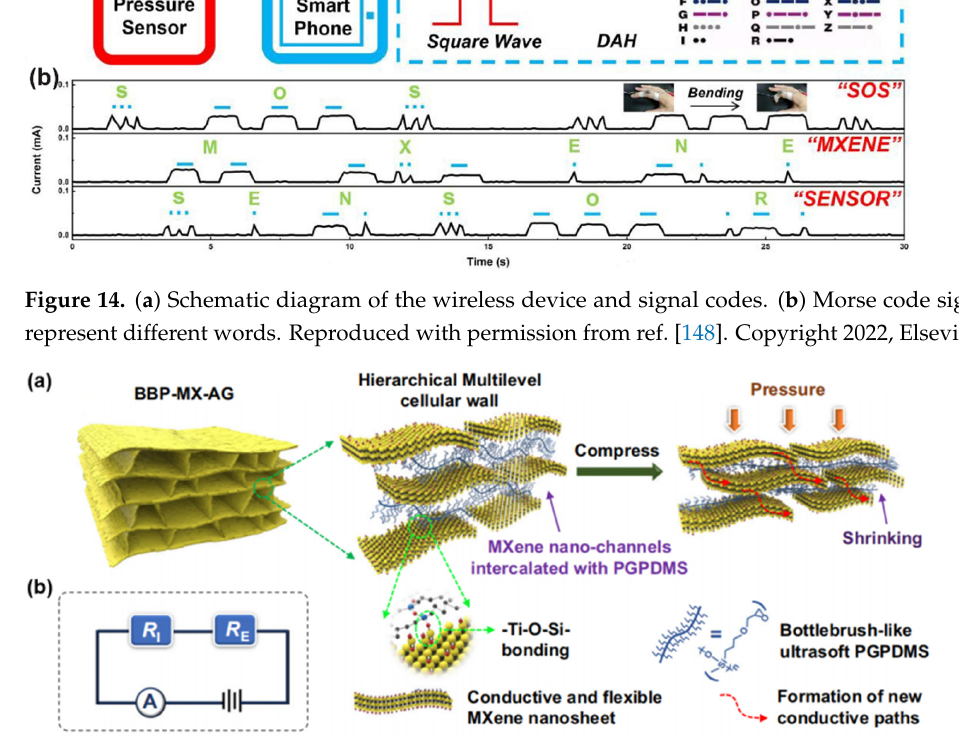
Figure 15. ( a ) Schematic illustration showing the MXene aerogel with sandwich-like structure, and the shrinking process of the multilevel cellular wall with bottlebrush-like PGPDMS crosslinked MXene nanochannels under compression. ( b ) Equivalent circuit diagram of this piezoresistive sensor. Reproduced with permission from ref. [149]. Copyright 2022, Springer Nature.